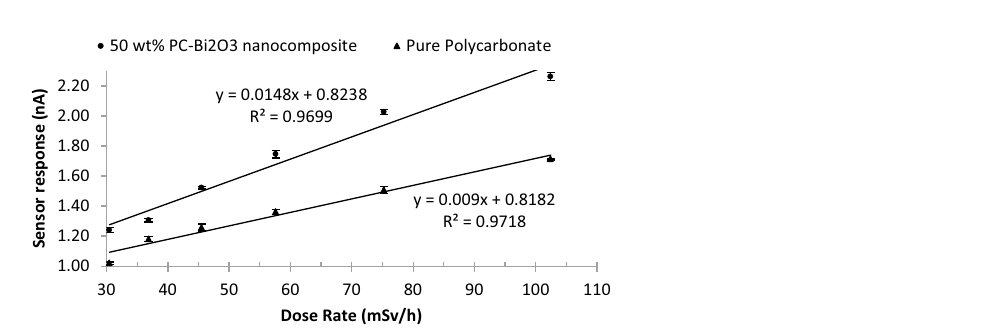
Figure 7. Sensor response of two materials against the 90 Sr exhibiting a maximum 1.9% standard deviation